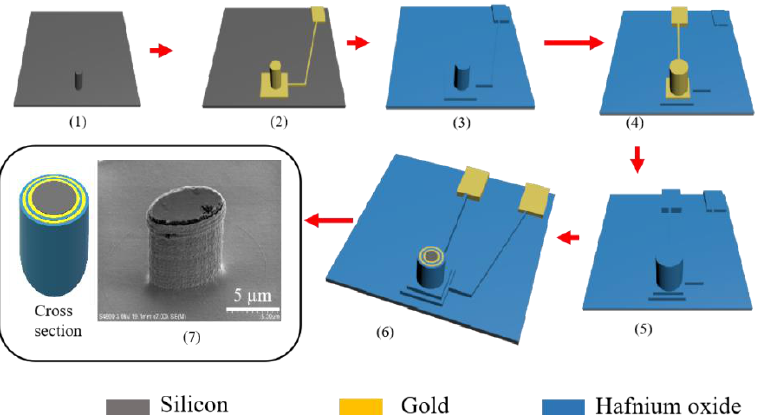
Figure 1. Au NREs fabrication flow diagram. ( 1 ) ICP dry etching of silicon micropillar; ( 2 ) inner Au electrode patterning (generator electrode); ( 3 ) ALD deposition of HfO 2 insulation layer; ( 4 ) outer Au electrode patterning (collector electrode); ( 5 ) ALD deposition of outer HfO 2 insulation layer; ( 6 ) defining the Au NRE via etching HfO 2 − Au − HfO 2 − Au sequentially; ( 7 ) SEM image of the NREs on the micropillar.